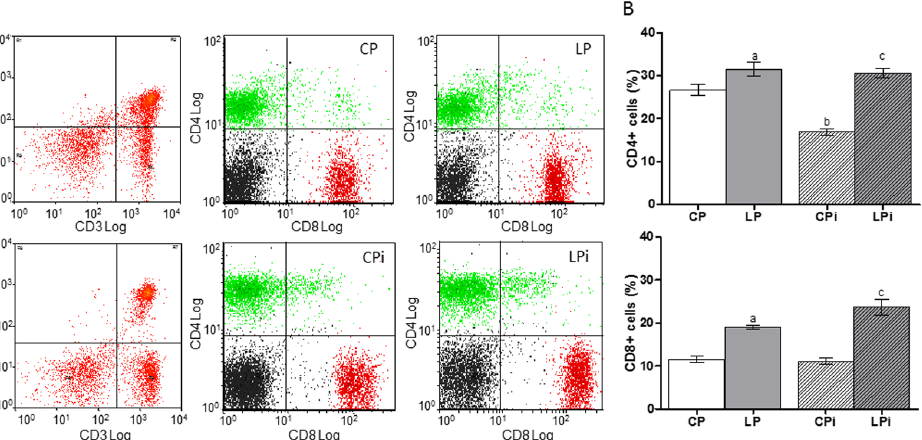
Fig. 6. Protein malnutrition dysregulated lymphocyte subpopulations in the spleen of mice infected with L. infantum . Lymphocyte subpopulations from the spleen of the experimental groups were measured using FACS analysis as described in the Materials and Methods. ( A ) Representative scatter plots of lymphocyte subpopulations. ( B ) Distribution of lymphocyte subsets expressed as percentage ¡ SEM. CP: animals fed 14% protein diet; LP: animals fed 4% protein diet, CPi: animals fed 14% protein diet and infected; LPi: animals fed 4% protein diet and infected. Two-way ANOVA analysis with Bonferroni pos-hoc test. Statistical differences due to diet: a (p , 0.001), infection: b (p , 0.05) and interaction between diet and infection: c (p , 0.05).